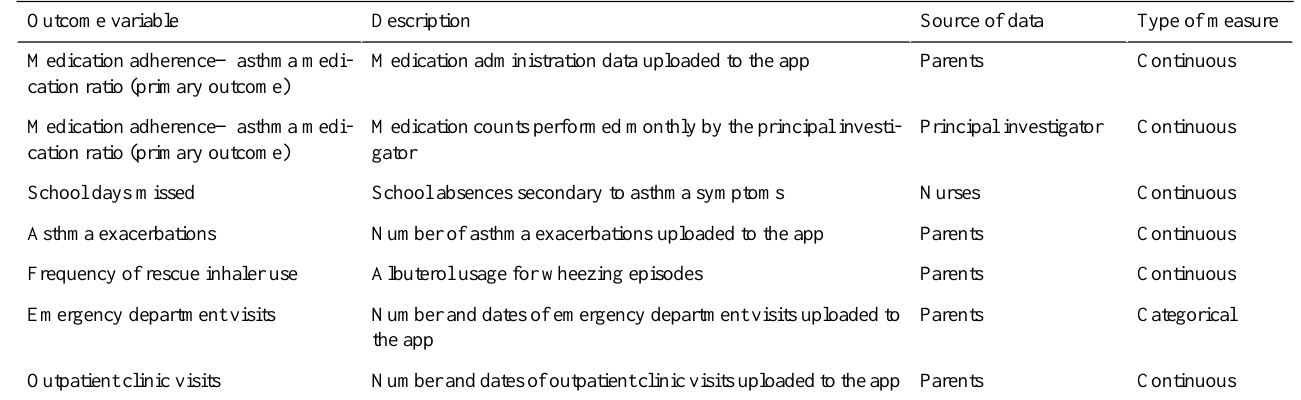
Table 2. Outcome measures and their